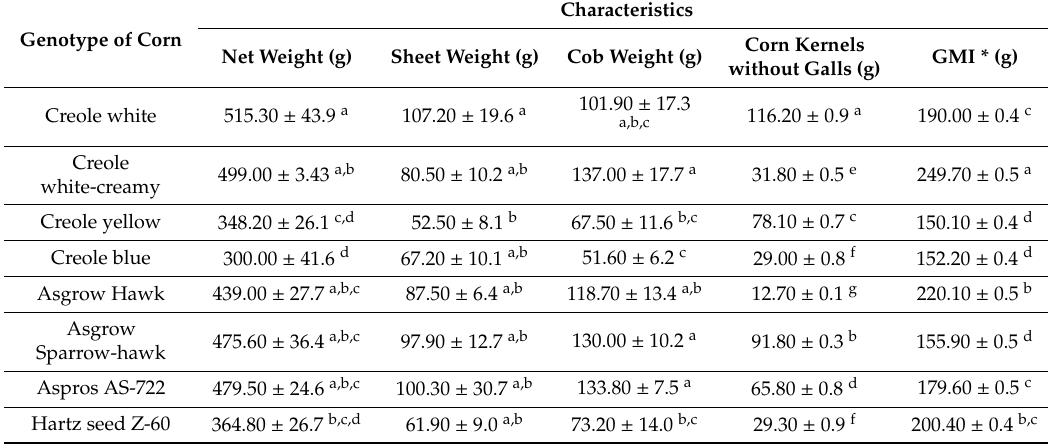
Table 2. Weight of corn cobs infected by the MA-Um1 strain in Nopalucan, Puebla, Mexico.